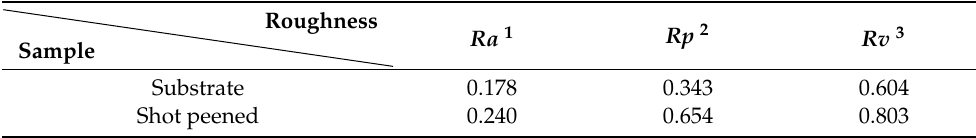
Figure 5. 3D contour profiles of the ( a ) ground substrate and ( b ) shot-peened sample. Table 1. The roughness values (in μ m) of the tested samples.